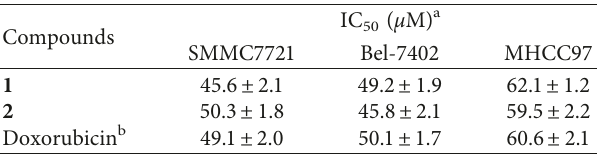
a Drug concentration required to reduce cancer cell growth by 50%; b the